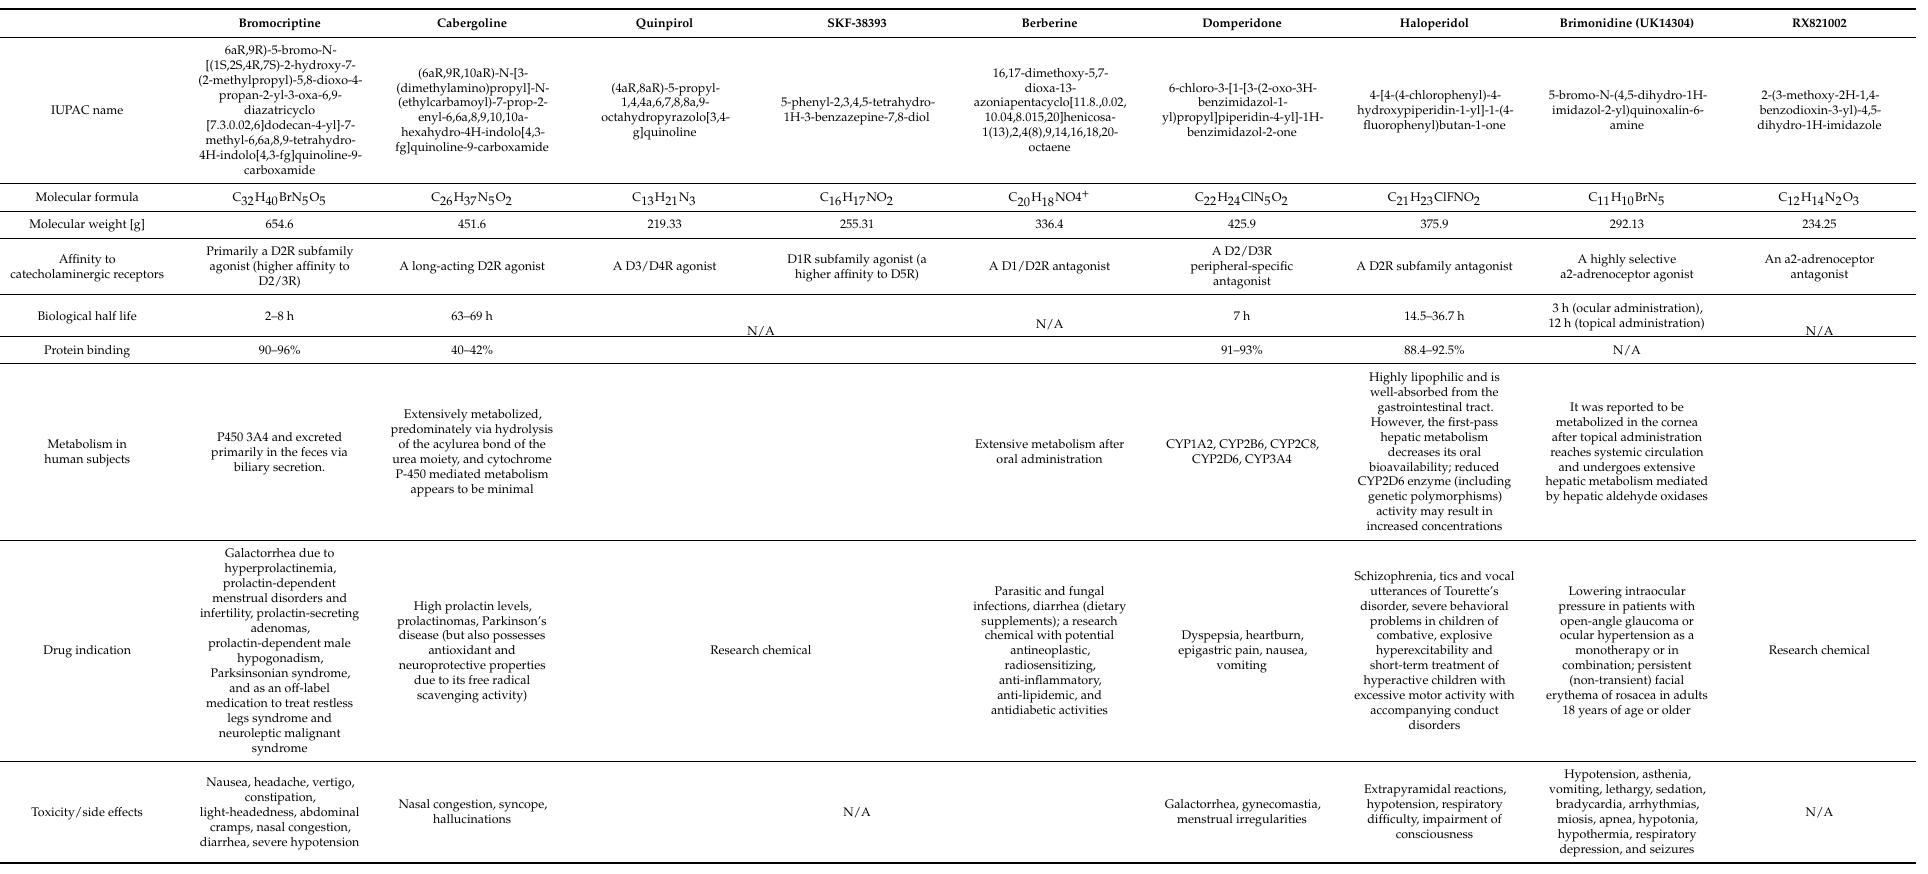
Table 3. Brief characteristics of compounds with affinity to dopamine and adrenergic receptors applied in the reviewed in vivo studies, based on the open chemistry PubChem database (https://pubchem.ncbi.nlm.nih.gov) as well as other directly linked databases (accessed on 10 and 18 August 2021). Abbreviations: DR: dopamine receptors; N/A: not